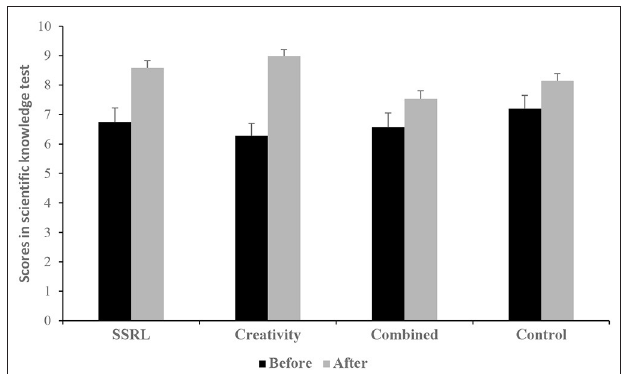
FIGURE 1 | Means (and SE) of the scores in the scientific knowledge test by group and